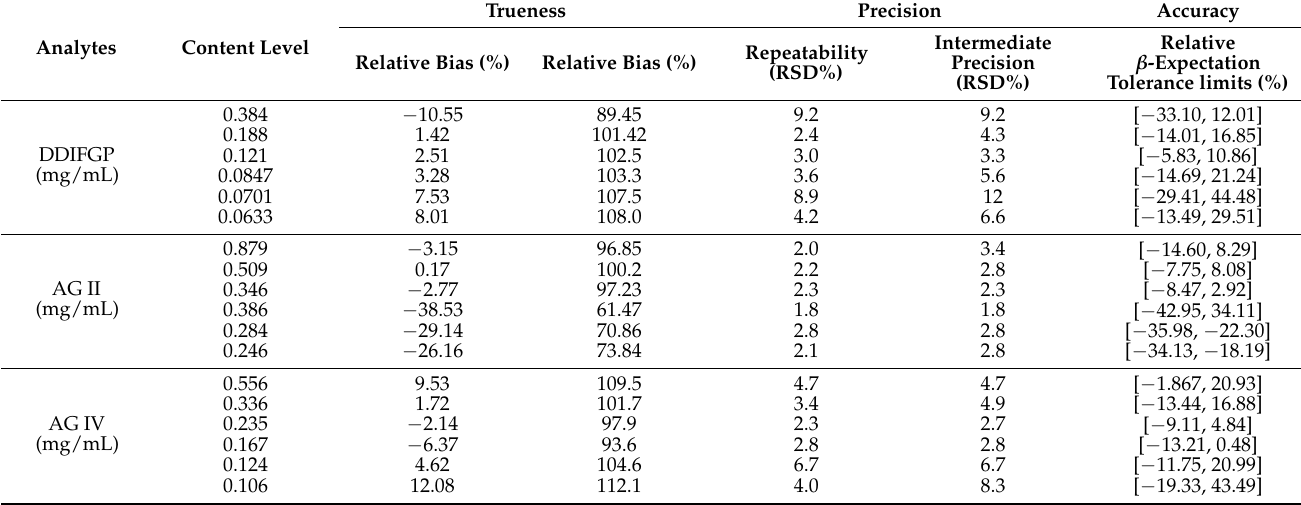
Table 7. Validation criteria of trueness, precision, and accuracy of the models for the 7 analytes.